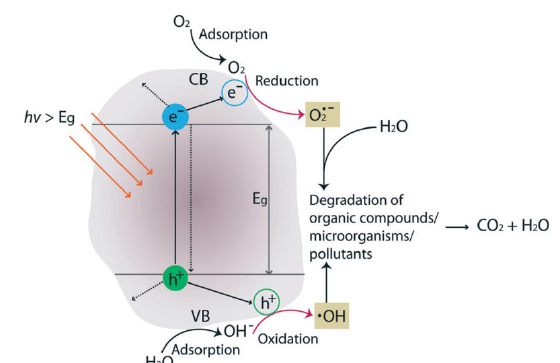
Figure 7. The photocatalytic effect of a catalyst upon light irradiation, including the formation of reactive oxygen species (ROS) and final products. Reproduced from [166] with permission from The Royal Society of Chemistry, Copyright